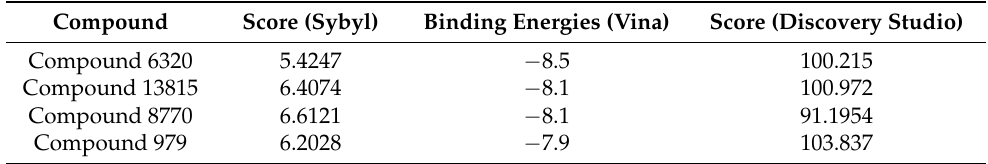
Table 2. Scores obtained for the three docking